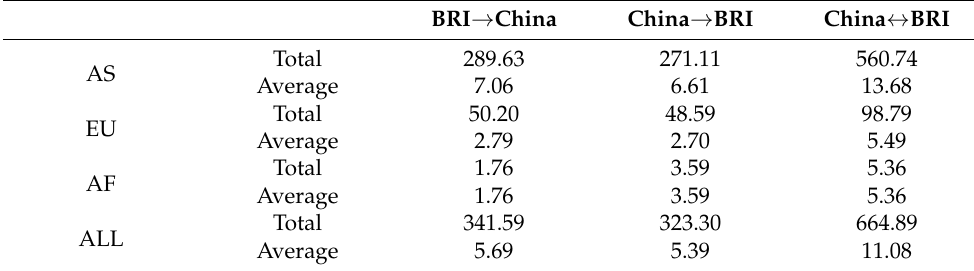
Table 1. The intermediate product trade between China and BRI countries (US$